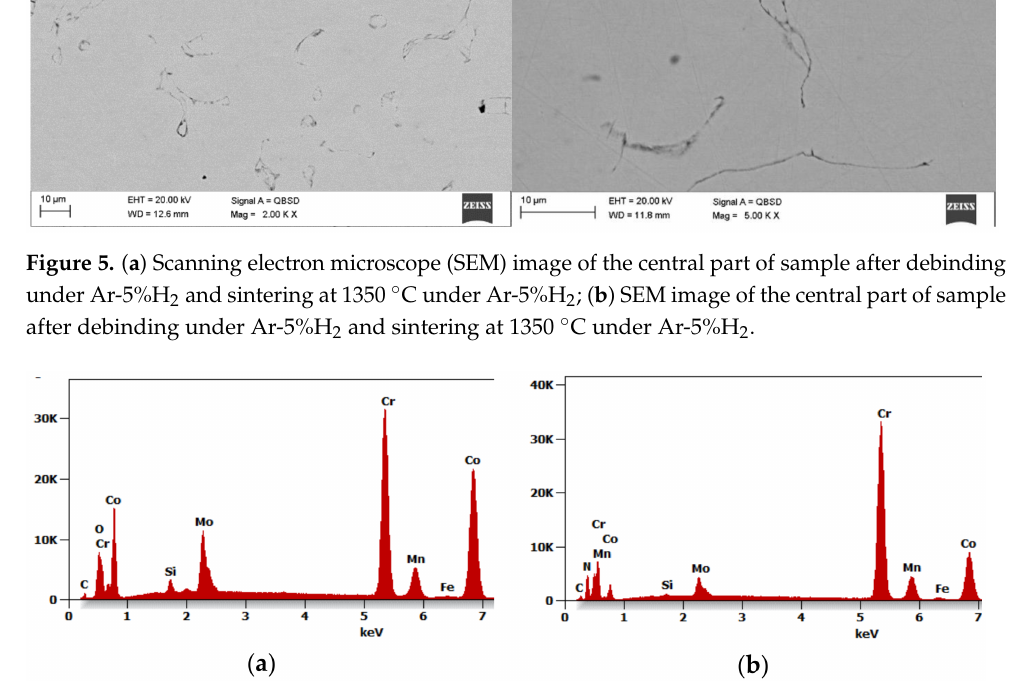
Figure 6. ( a ) Energy-dispersion spectrometer (EDS) analysis from selected area in Figure 10a; ( b ) EDS analysis from selected area.